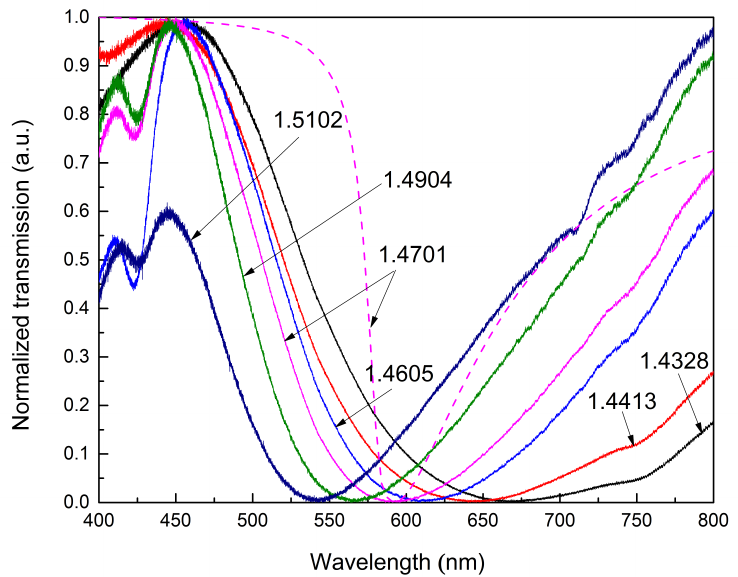
Figure 4. Normalized transmission spectra of ETFE HF-SPRS with different n corresponding n is labeled in the s